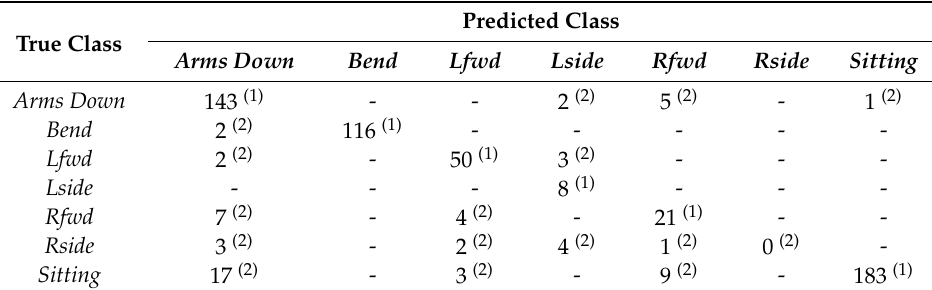
Table 7. Confusion matrix created from the actions predictions.